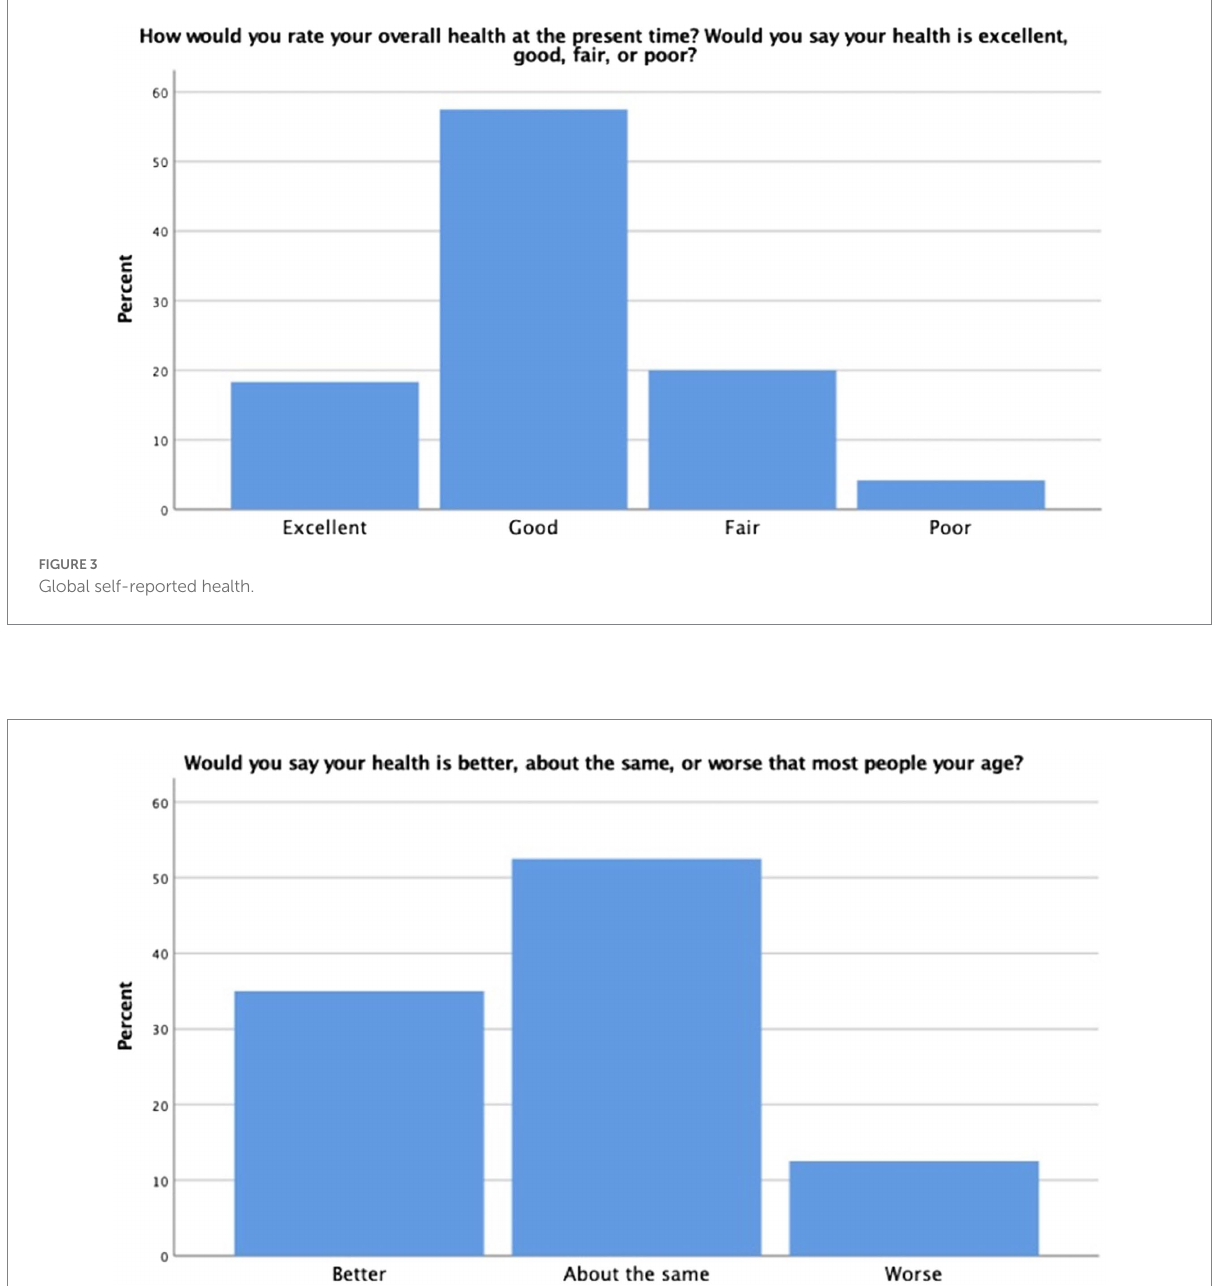
FIGURE 4 Age comparative